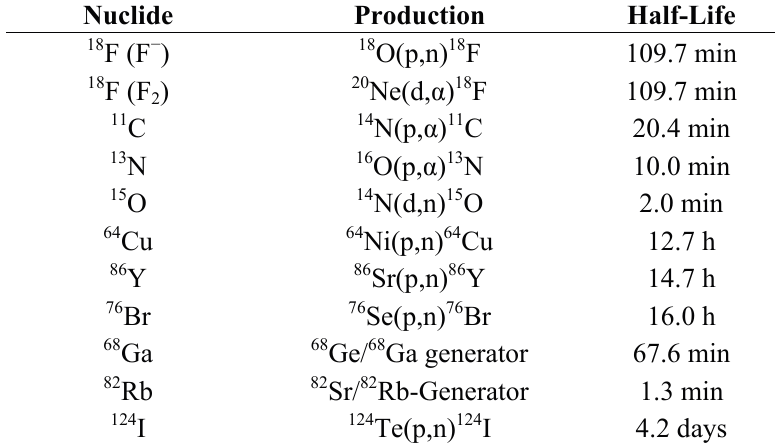
Table 1. Important PET radionuclides and their common way of